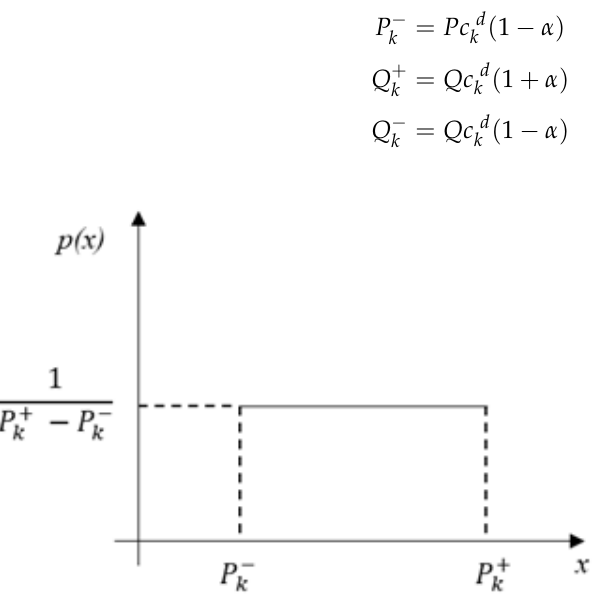
Figure 2. Uniform Probability Density Distribution for Active Power.